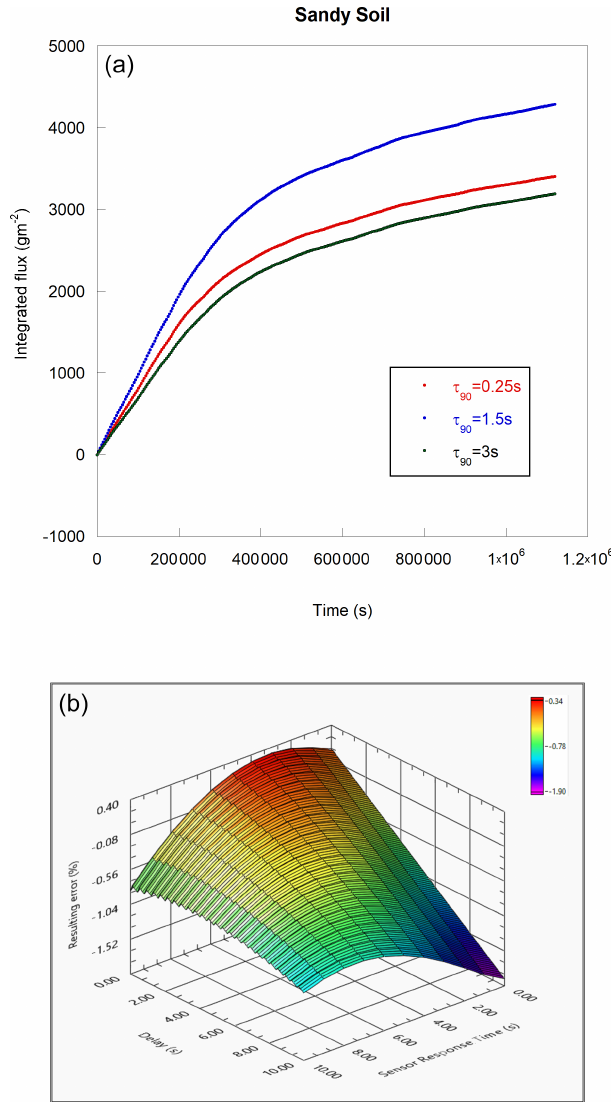
Figure 3. (a) Integrated ME given by three different sensors with different response times. BME280 and 3s response time, P14 Rapid with 1.5s response time and F-Tuta 34 which has the faster response time of 0.25s. Unfortunately, this sensor quickly malfunctioned and then was discarded. (b) Simulation of the ER regression error due to a slow sensor and introduced waiting delay with the origin of the time